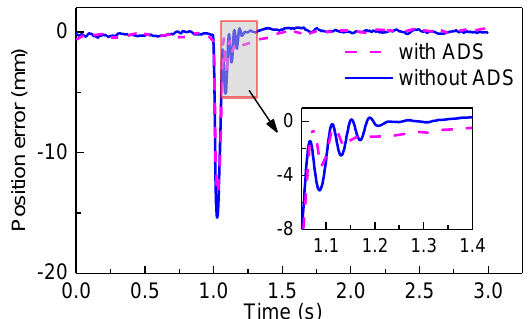
Appl. Sci. 2019 , 9 , x FOR PEER REVIEW